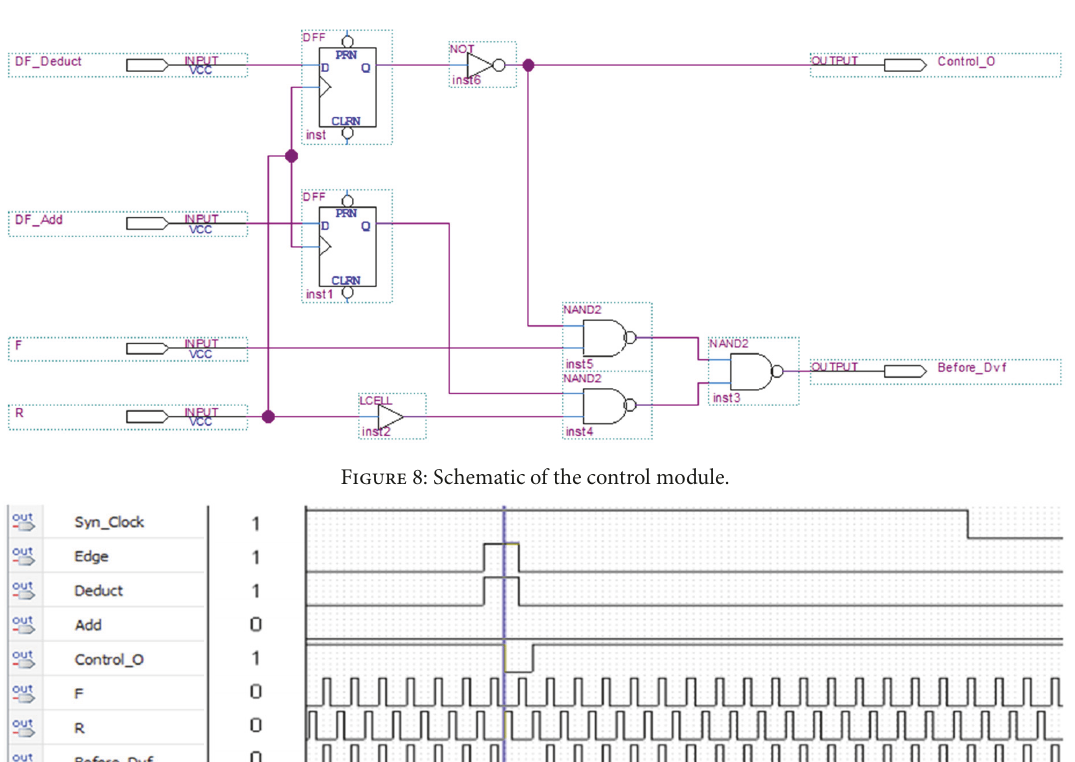
Figure 7: Simulation result of biphasic clock source circuit.